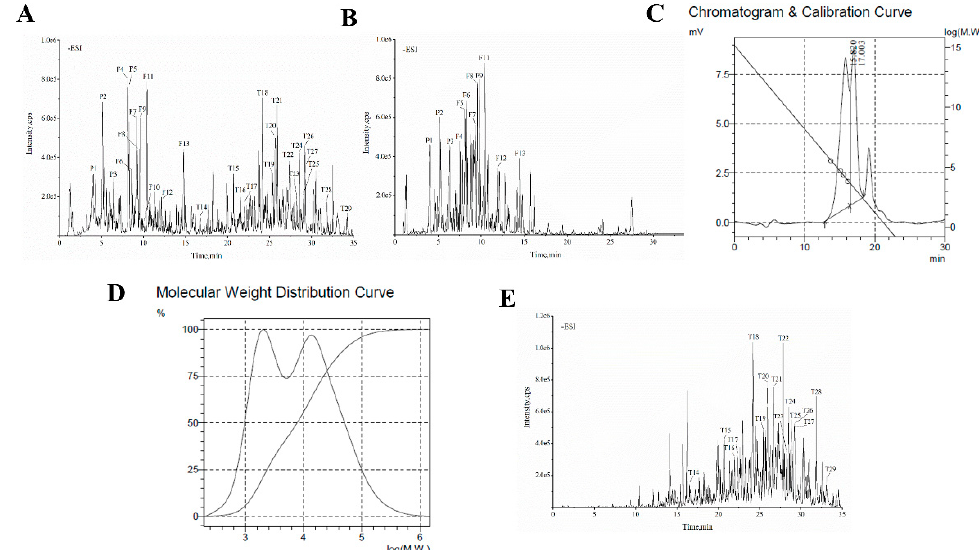
Figure 7. ( A ) Total ion chromatograms of CPE (ethanol extract from C. paliurus leaves, ( B ) CPF (flavonoids fraction from C. paliurus leaves), and ( C ) CPT (triterpenoids fraction from C. paliurus leaves), in negative ion mode. ( D ) Chromatogram and calibration curve of CPP. ( E ) Molecular weight distribution curve of CPP. Table 1. Identification of the chemical constituents in CPE by HPLC-ESI-Q-TOF-MS/MS.